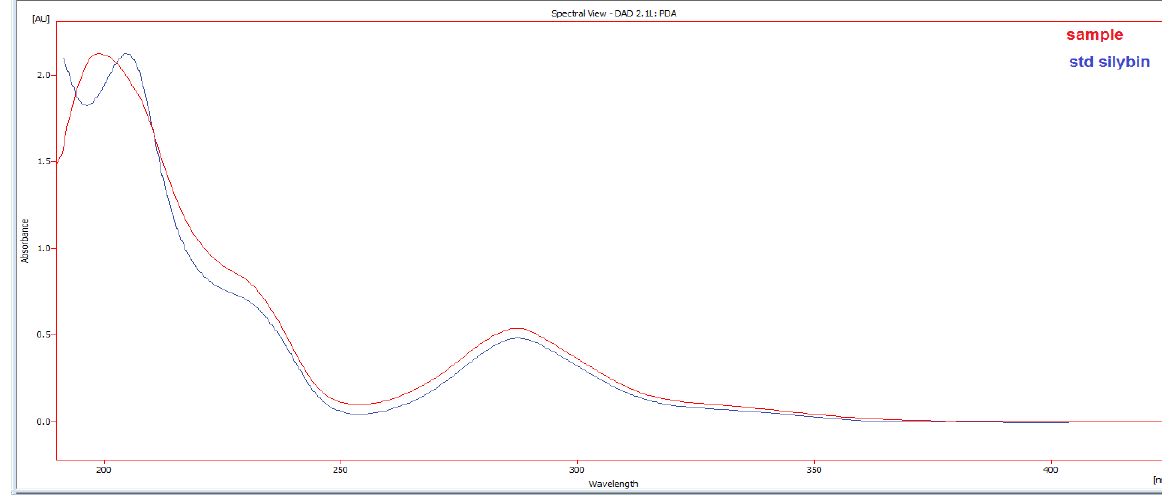
Figure 6. UV spectrum of fraction of ethyl acetate matched with silybin standard UV spectrum.